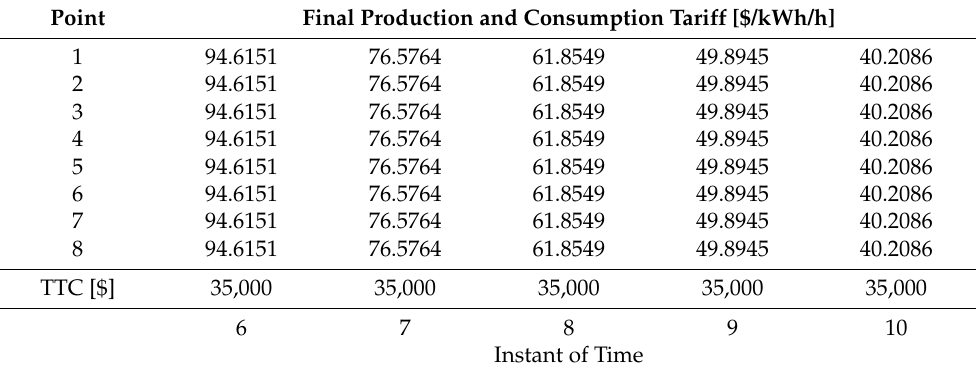
Table 5. Final production and consumption tariffs for each point and the total transportation cost between the instants of time 6 and 10 with W F = 0.